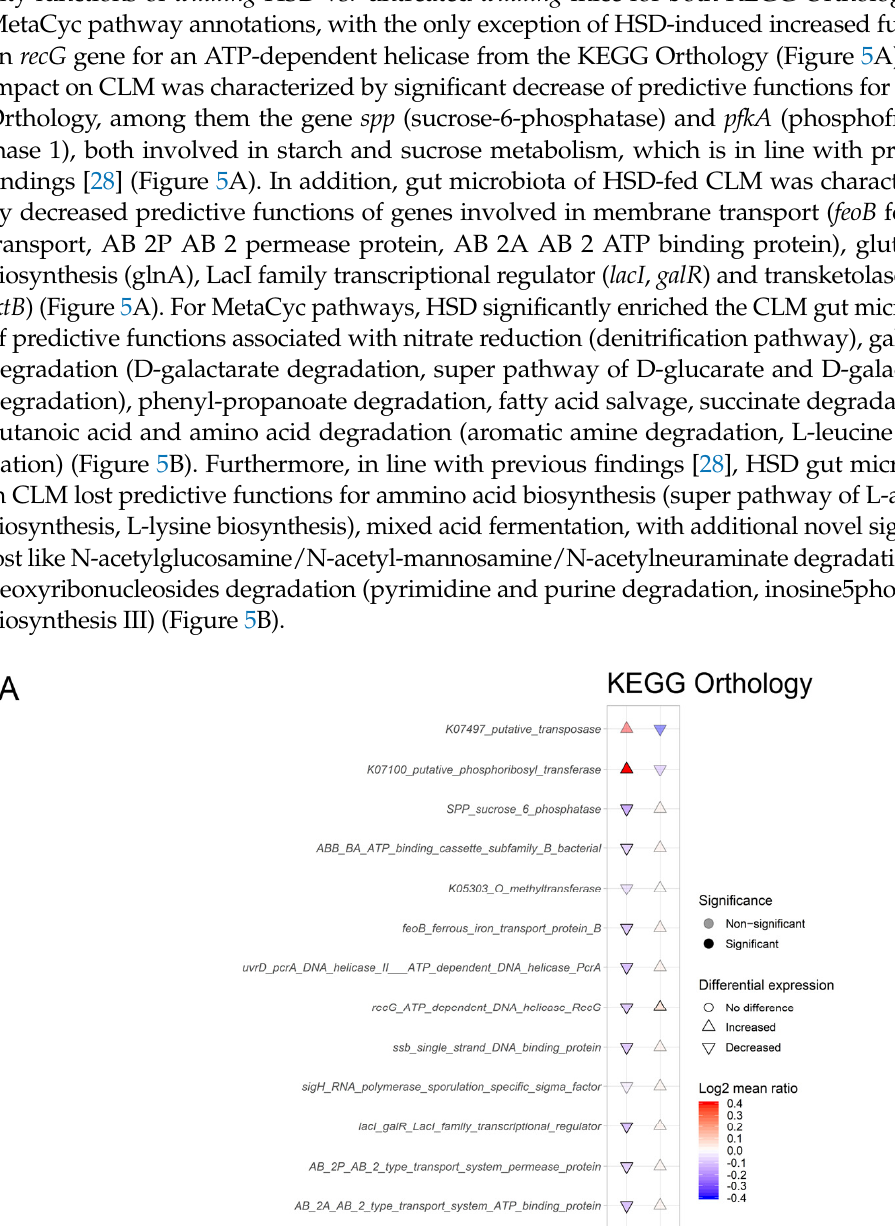
Figure 5. E ff ect of HSD on gut predictive metagenomic functions in CLM (n = 10/group) and wildling (n = 11 for wildling Ctrl and n = 12 for wildling HSD) gut microbiota. PICRUSt2 output plo tt ed as cuneiform plot for KEGG Orthology annotation ( A ) and MetaCyc pathways ( B ) expressed as log2 mean ratio of the predictive functions counts between HSD vs. Ctrl samples. All statistical comparisons were performed between Ctrl vs. HSD groups by Wilcoxon-test.